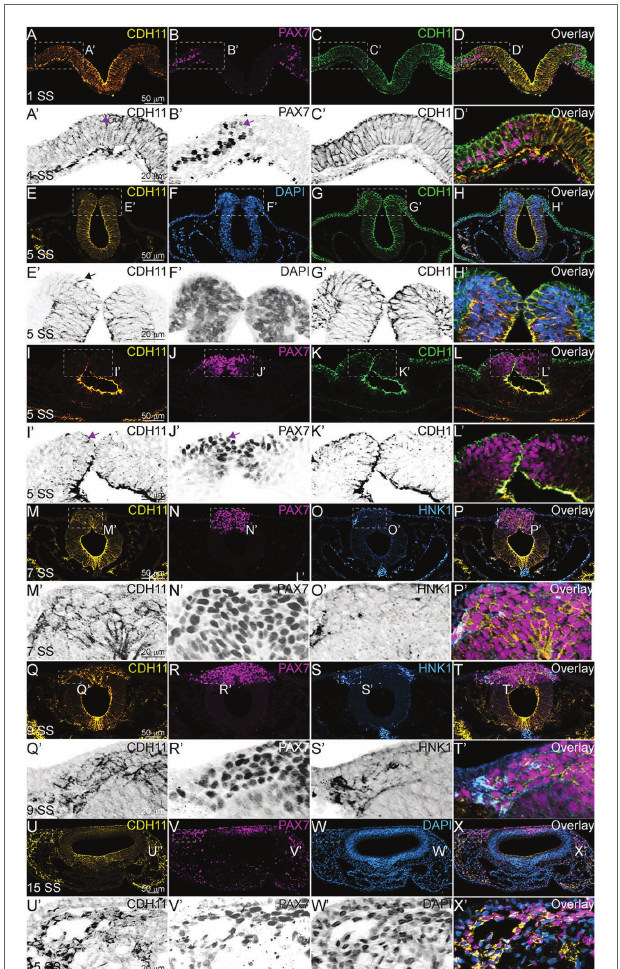
FIGURE 1 | CDH11 expression in NC cells starts during specification stages. (A–X’) Immunohistochemistry (IHC) using antibodies against CDH11 (yellow), PAX7 (pink) to mark NC cells and neural plate border, CDH1 (green) to mark cell-cell junctions and epithelial tissues, and HNK1 (blue) to mark migratory NC cells as well as parts of the endoderm, mesoderm, and notochord, or stained with DAPI (blue) to mark nuclei. At (A–D’) HH7[1 somite stage (SS)], when NC are induced at the neural plate border, CDH11 is expressed in the neural plate/ tube, but is only expressed in a subset of border cells with PAX7. Examples of cells positive for both PAX7 and CDH11 are marked with pink arrows. (E-H’, I-L’) At HH8 (5 SS), CDH11 co-localizes with CDH1 in the developing neural tube. Black arrow marks cell in premigratory NC region positive for CDH11. (M–P’) At HH9 (7 SS) is strongly upregulated in the premigratory NC cells marked by PAX7 and early migrating NC cells marked by HNK1. (Q-T’) At late HH9 (9 SS) expression is maintained in the NC cells undergoing EMT and migrating out of the neural tube. (U–X’) At HH11 (15 SS), CDH11 expression is weaker in the neural tube and is maintained in the migratory NC cells marked by PAX7. Dashed boxes indicate zoom regions depicted by grayscale images. Scale bars as indicated in first